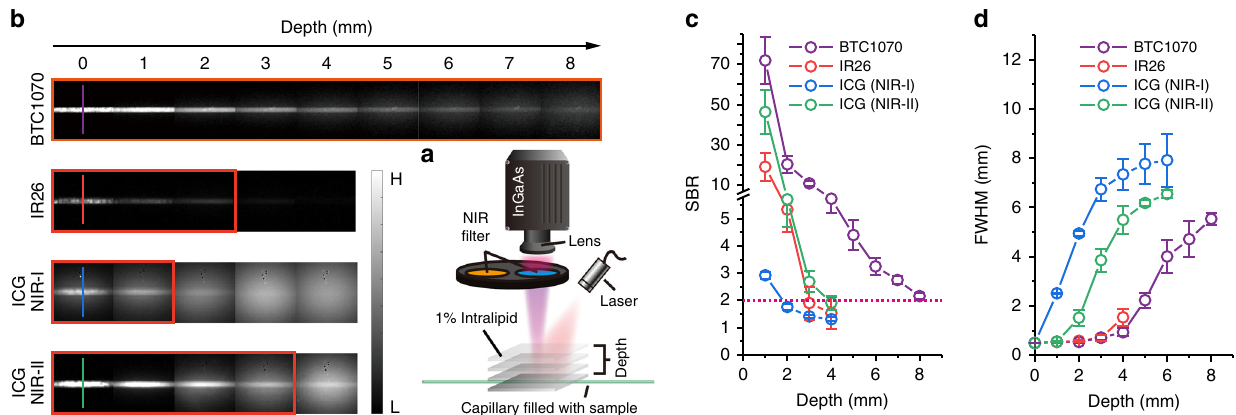
Fig. 3 Deep penetration of bright and long-wavelength BTC1070 in mimic tissue. a A home-built NIR fl uorescence imaging setup for tissue phantom study. b Fluorescence images of capillaries fi lled with BTC1070, IR26, and ICG in PBS (pH 7.4), respectively, immersed in 1% Intralipid with varying depth. BTC1070 and IR26 imaging signals were collected in 1200 – 1700 nm region under 1064 nm excitation. ICG imaging signals were collected both in NIR-I (850 – 950 nm) and NIR-II (1000 – 1700 nm) region under 808 nm excitation. Color bar ranges from 0 to 20,000 for BTC1070 and ICG, 0 – 5,000 for IR26. The detailed imaging parameters for each image are listed in Supplementary Table 1. c Measured signal-to-background ratio (SBR, de fi ned in Supplementary Figure 8) of capillary images as a function of depth. By selecting a threshold SBR (SBR = 2, red dotted line) to de fi ne the level at which structure are minimally resolvable, the maximum penetration depth range for all fl uorophores are showed as origin boxes in b . The bars represent mean ± s. d. derived from n = 3 line pro fi les measured at different positions in the capillary images. d Wavelength-dependent full-width at half-maximum (FWHM) of cross-sectional pro fi les in capillary images as a function of depth. The bars represent mean ± s.d. derived from the uncertainty in the Gaussian fi tting of feature width. Source data are provided as a Source Data fi